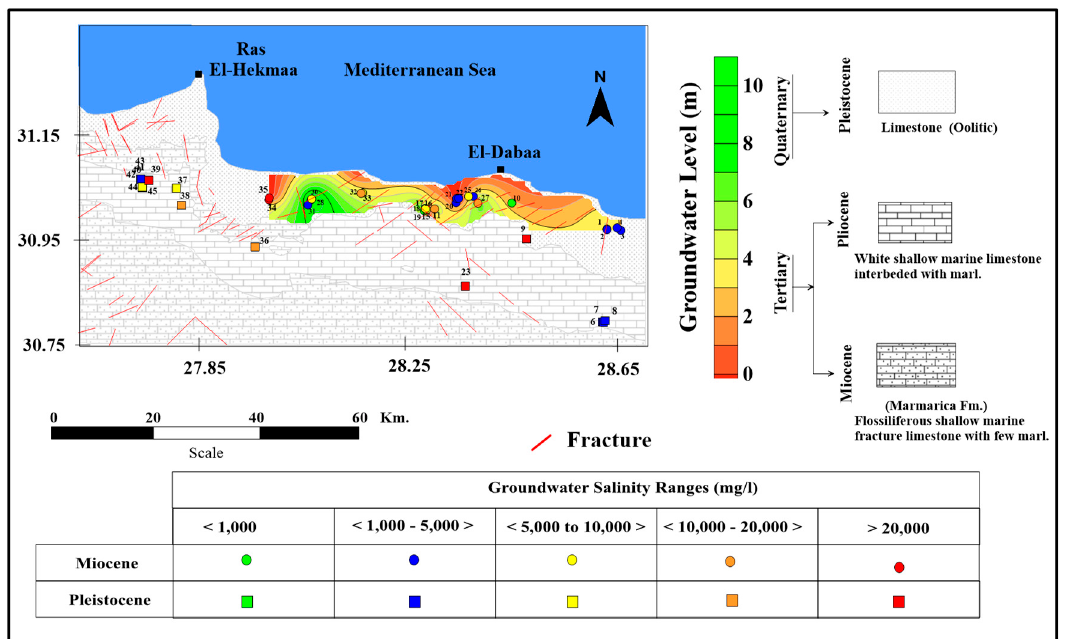
Figure 2. Geological map along the northwestern coastal zone.